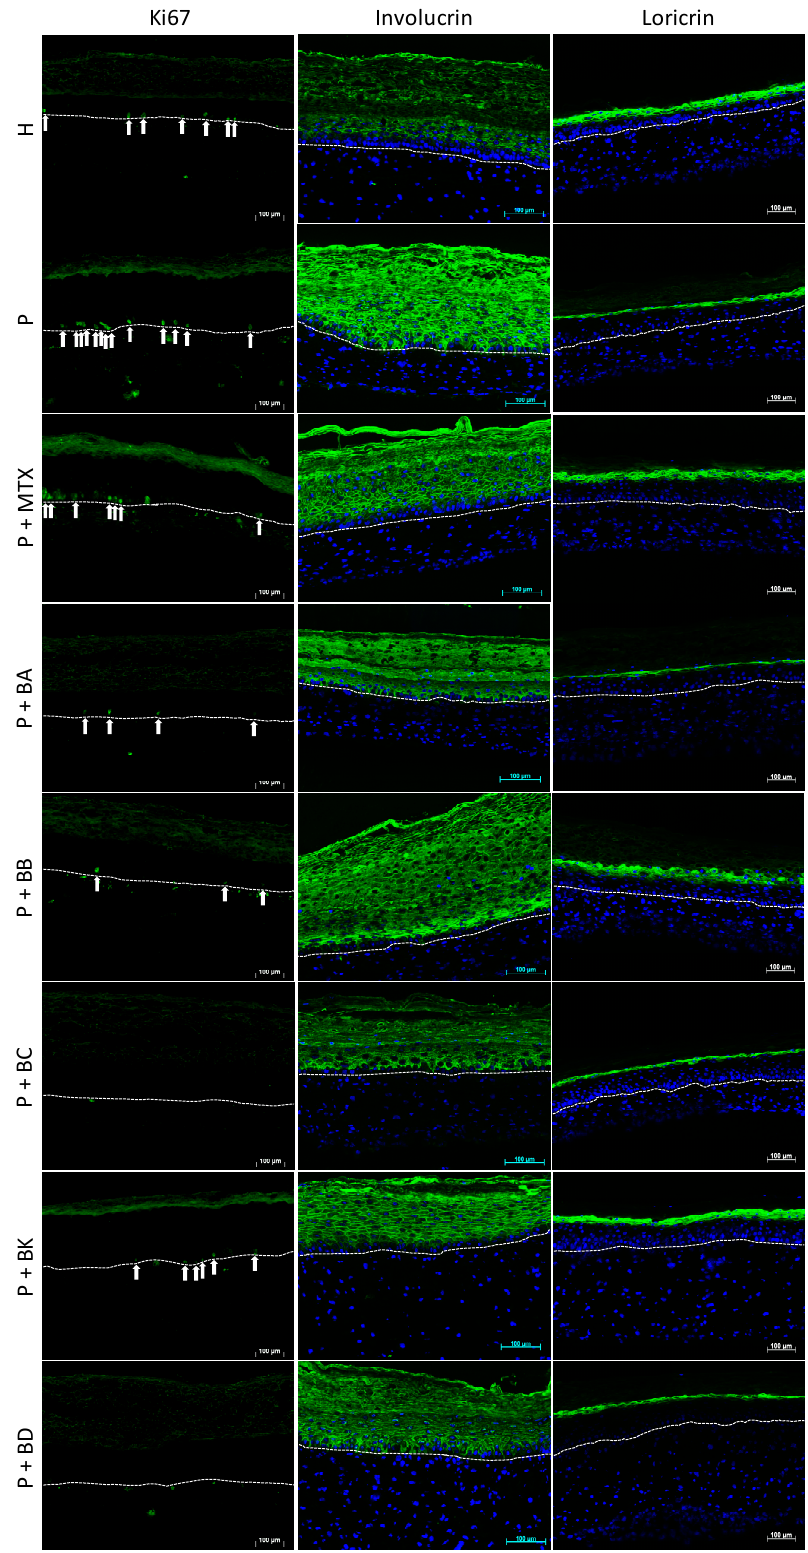
Figure 4. Immunofluorescence staining. Expression of Ki67 (green, stained cells are indicated with arrows), involucrin (green) and loricrin (green) monitored in healthy (H) or psoriatic (P) skin substitutes treated or not with methotrexate (MTX), balsacone A (BA), balsacone B (BB), balsacone C (BC), (±)-balsacone K (BK), and (±)-iryantherin-D (BD). Nuclei were stained with Hoechst (blue). Three substitutes of each condition were analyzed and the results were confirmed with two independent experiments. (Scale bar = 100 µm).